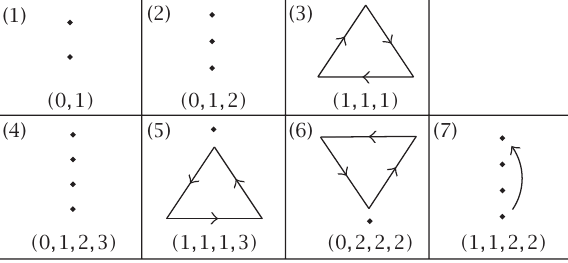
Figure 2.1 Isomorphism classes of n -tournaments for n = 2 , 3 ,